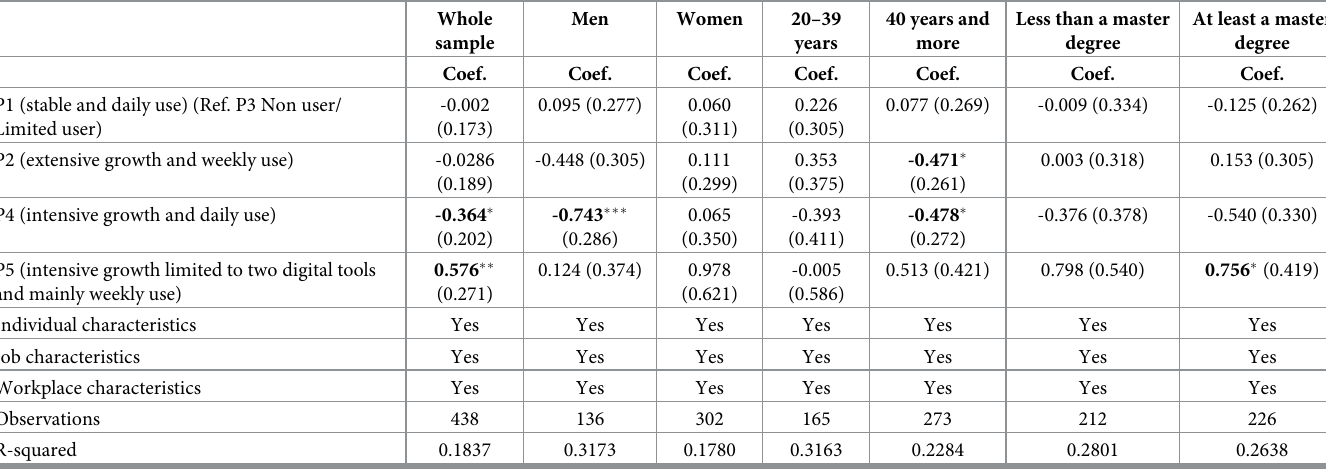
Table 6. Collaborative and communication digital profiles and the evolution of job productivity before and during the lockdown by sub-samples (ordered probit model).